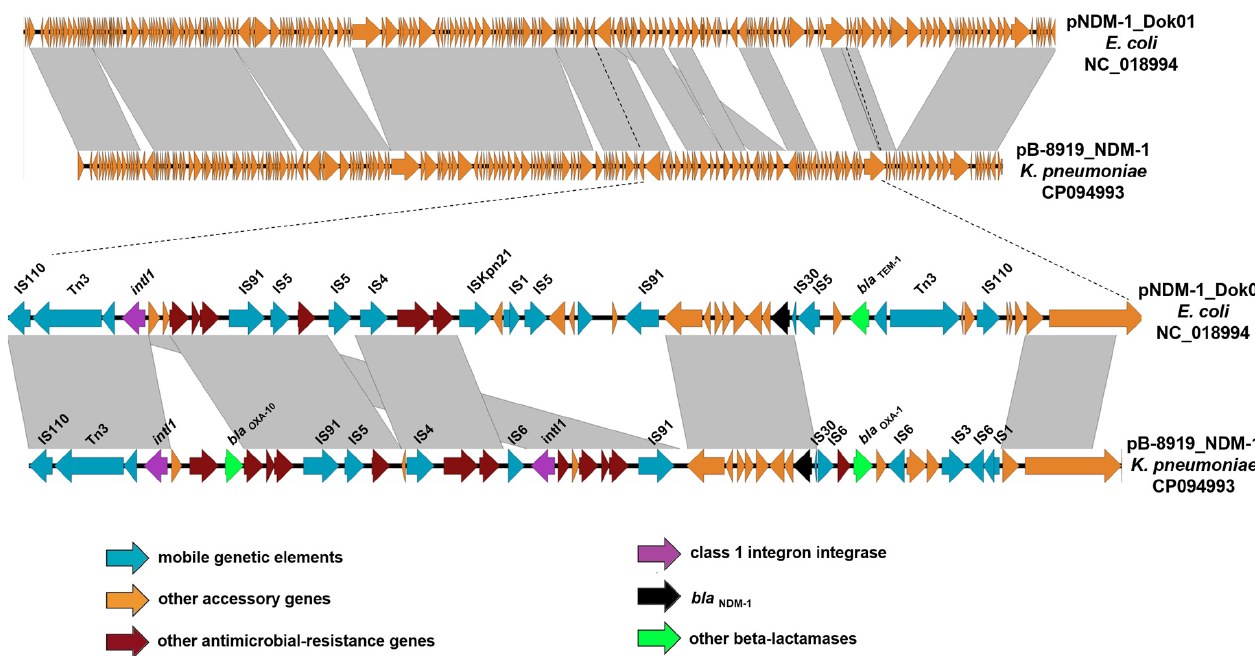
Figure 3. Easyfig comparison of IncC plasmids pB-8919_NDM-1 ( K. pneumoniae strain SCPM-O-B- 8919), pNDM-1_Dok01 ( Escherichia coli strain NDM-1 Dok01), and the genetic environment of the genes bla NDM-1 , bla OXA–10 , and bla OXA–1 . The arrows show the orfs , their length, and their orientation.